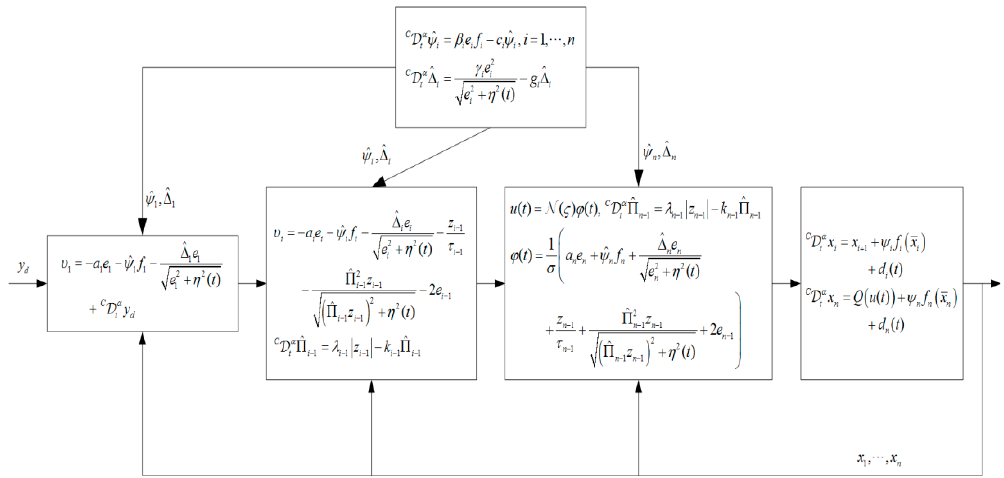
Figure 1. Block diagram of control system.